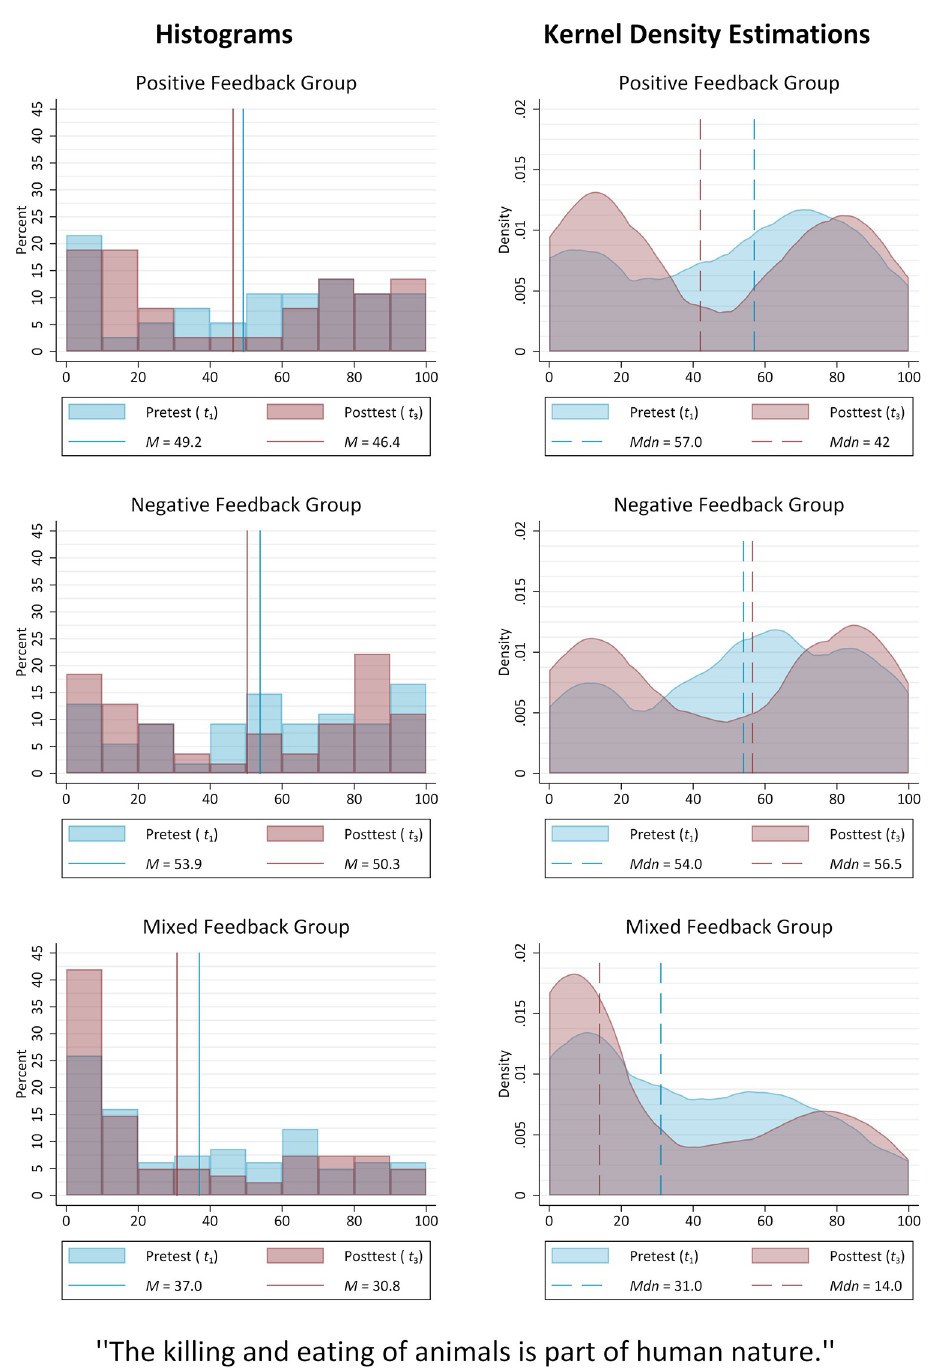
Fig 3. Target item distributions (treatment groups). S OURCE : ODSF2018, own calculations. deviations of the respective mean value differences in Table 2 as well as the box plots, especially of the differences, as presented in Fig 4, illustrate the extent to which participants’ individual opinions varied over the course of the study. Ultimately, since the means of the group-specific absolute differences, ranging from M = 15.1 ( SD = 19.2) to M = 18.2 ( SD = 21.6), are